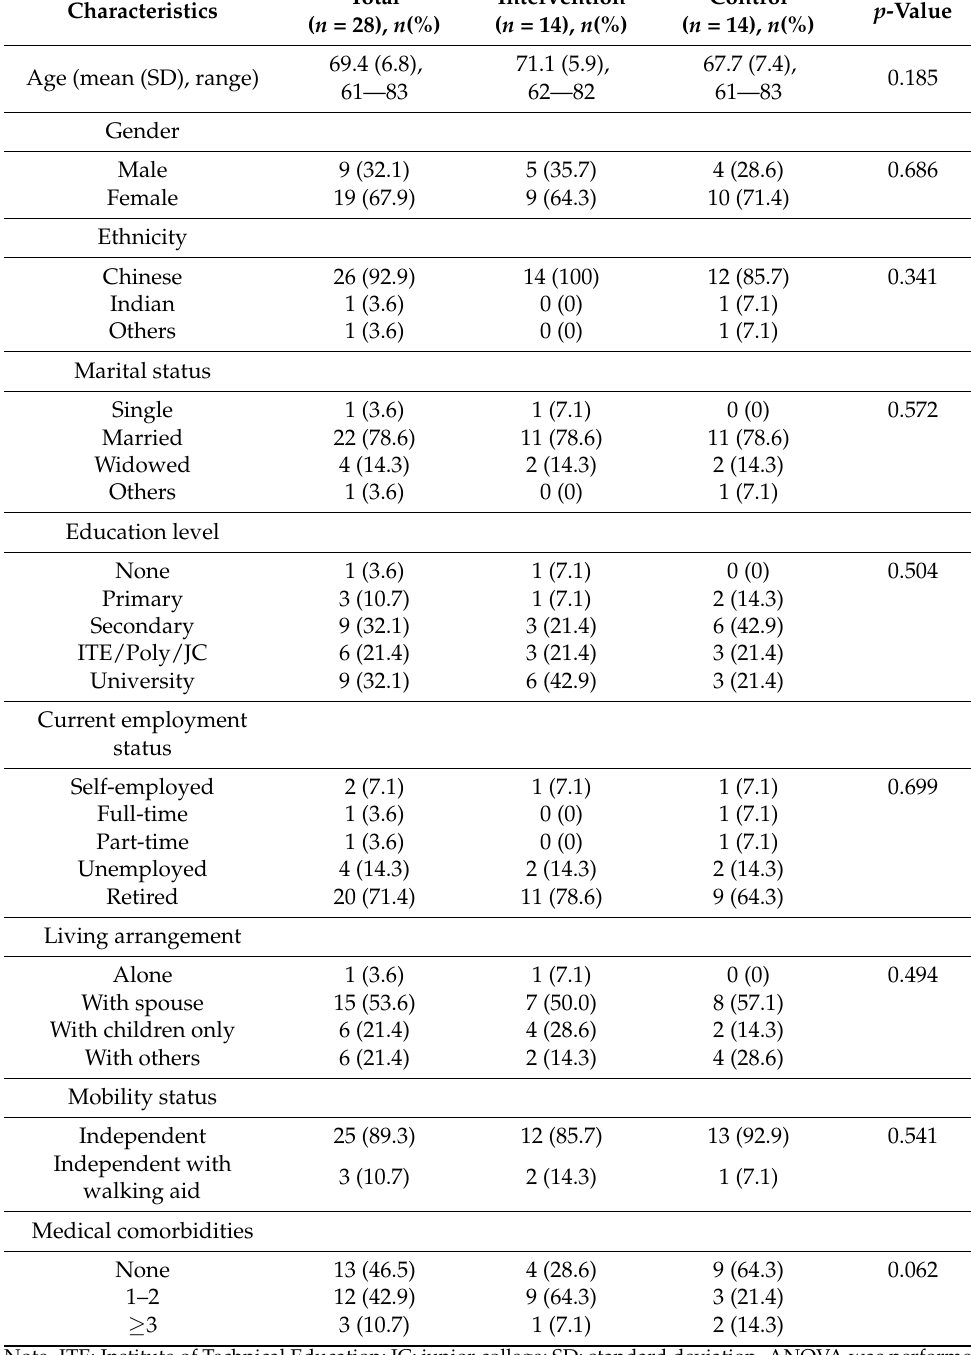
Table 1. Baseline characteristics of